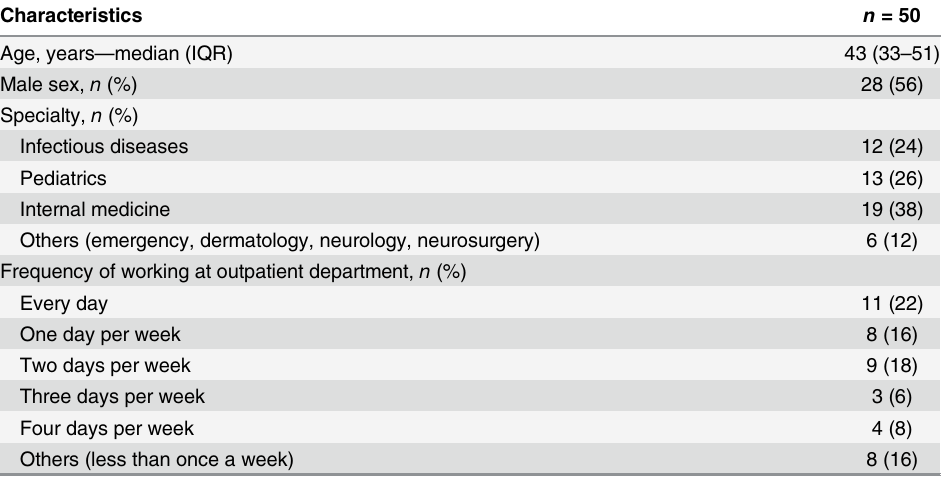
Table 1. Demographic characteristics of physicians who responded to the KAP survey.